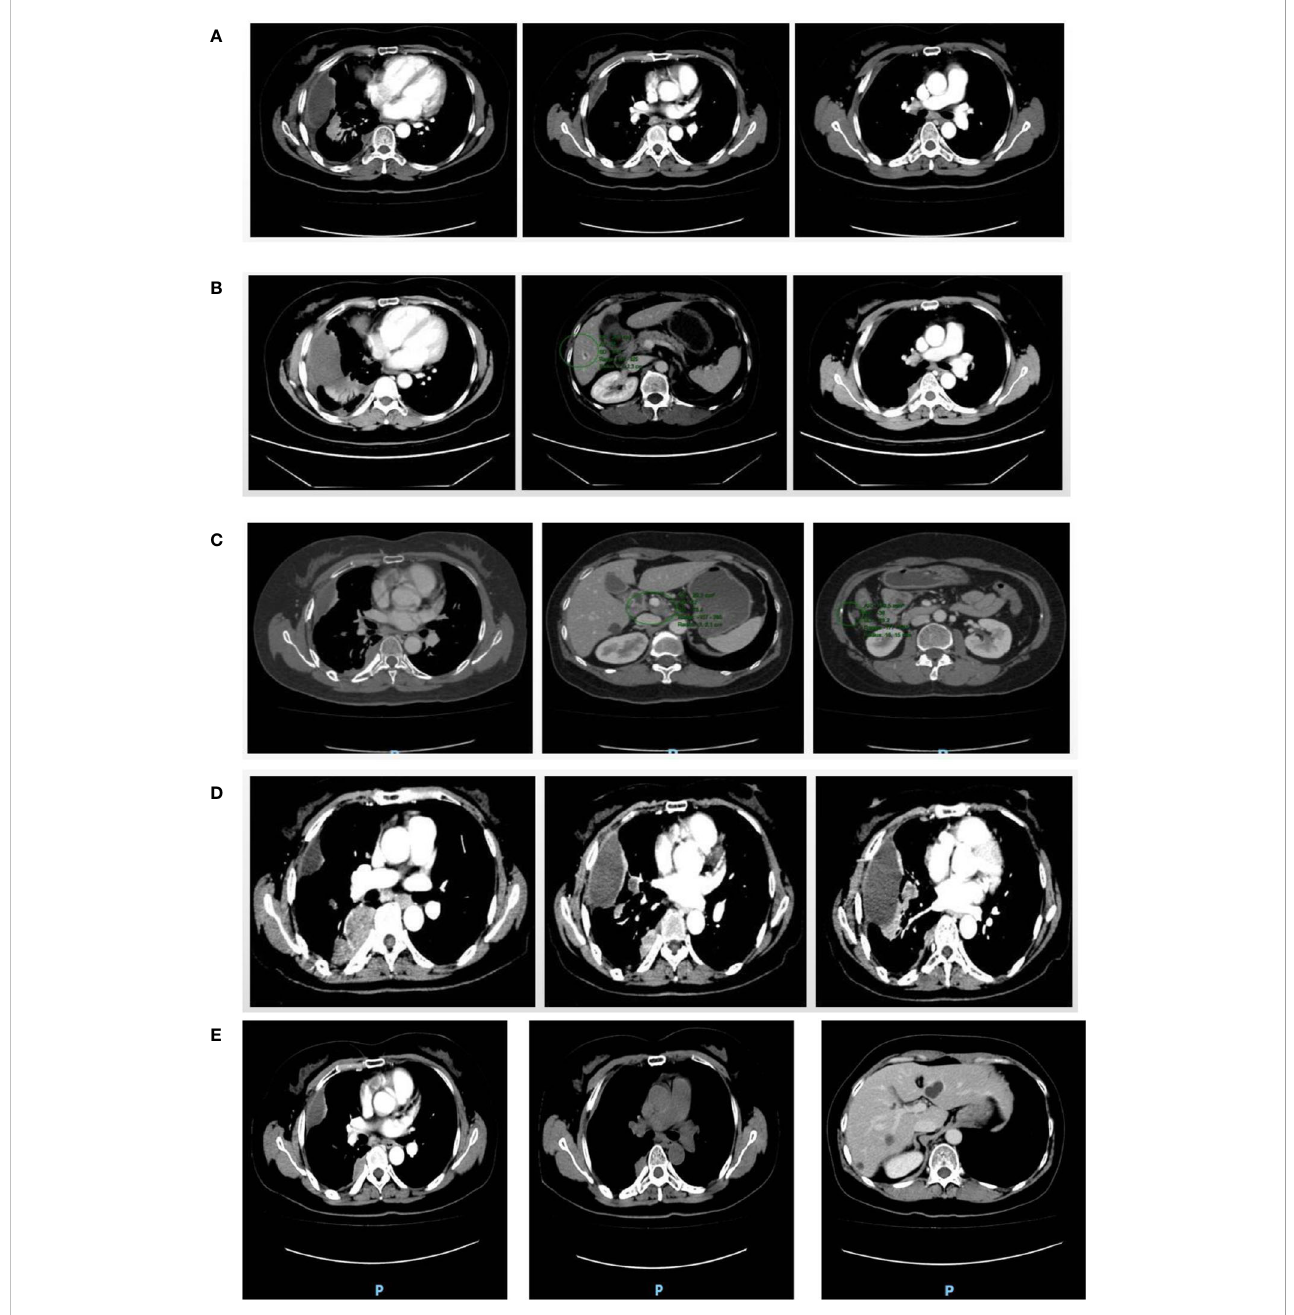
FIGURE 2 CT images. (A) Right pleura and interlobular pleura; (B) Right pleura and liver; (C) Right pleura; (D) Right pleura and right lung; (E) Right pleura and right lung and liver. (A) In December 2018, multiple small nodule foci were observed in the right pleura and interlobar pleura indicating the possibility of multiple metastases but smaller in size than earlier foci. (B) In October 2019, multiple metastases were observed in the right pleura, which were more and larger than previous lesions. The nodular foci were enhanced at the edge of the S6 segment of the liver. (C) In July 2020, multiple metastases in the right pleura were observed with no signi fi cant change in size and number compared with the previous lesions. A lymph node in the hilar region was observed swollen indicating lymph node metastasis. (D) In April 2021, multiple metastases that were larger in size and number were observed in the right pleura and right lung. Multiple enlarged lymph nodes were found in mediastinum and right hilar region. (E) In April 2022, the lesions in the right pleura and right lung were slightly smaller than before; the lesion in hepatic S6 segment was not signi fi cantly changed than